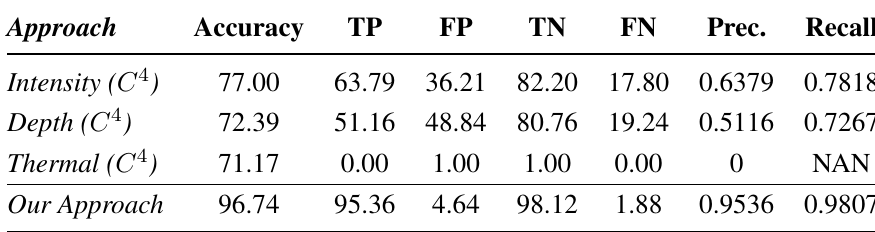
Table 10. Results obtained by the C 4 approach, compared with those obtained with the proposed